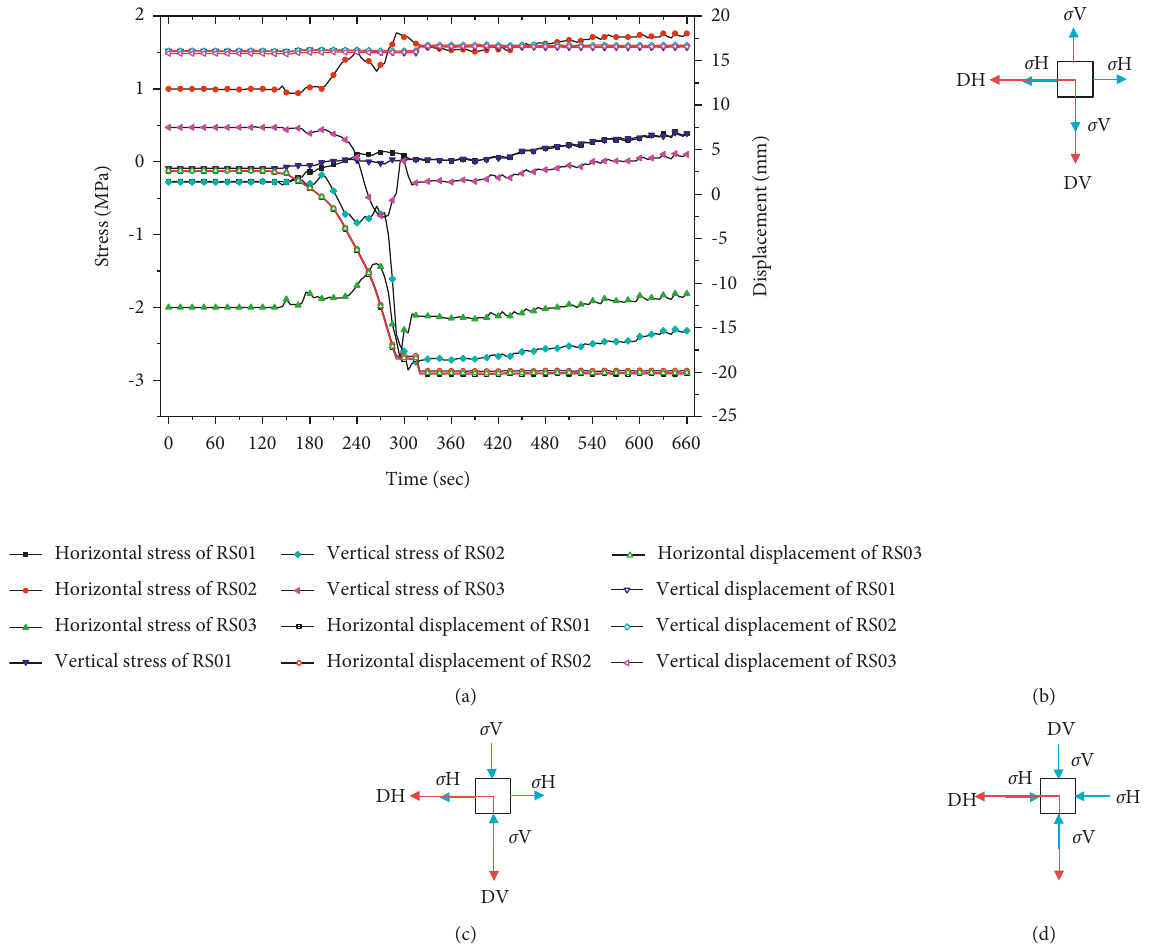
Figure 20: Stress and displacement of roadway right side measuring points when the cumulative duration is 539 to 550mins; (a) monitoring curve of RS01, RS02, and RS03; and (b–d) schematic diagram of RS01, RS02, and RS03, respectively.